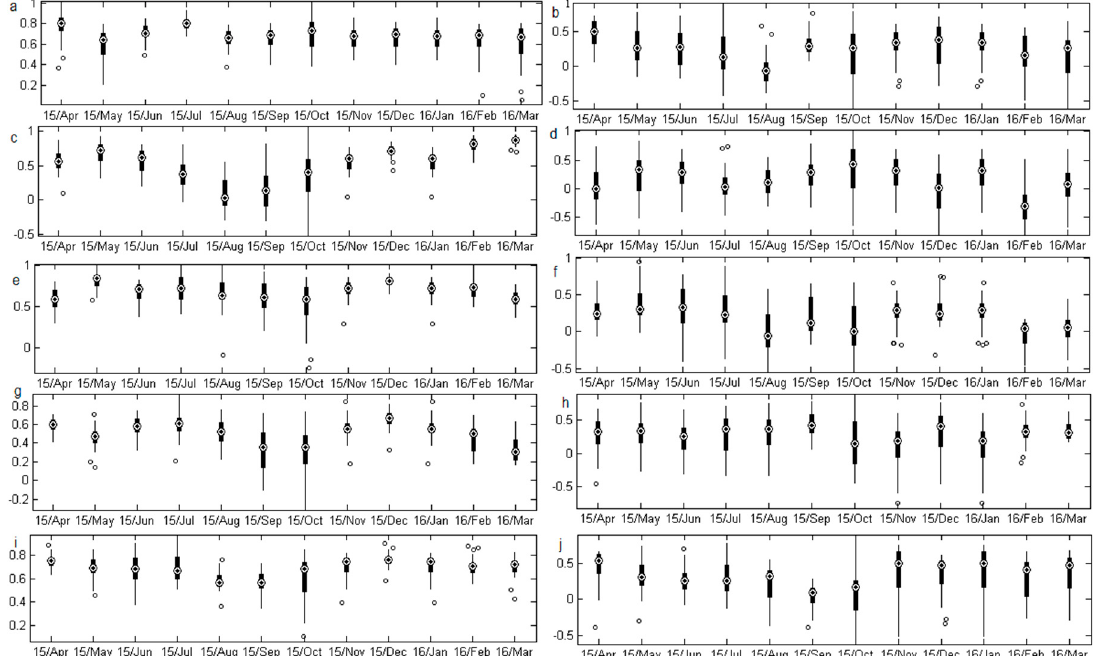
Figure 11. Temporal evolution of correlation between SMAP L4 ( a , c , e , g , i ) or AMSR2 L3 ( b , d , f , h , j ) daily average data and in situ soil moisture data with the Deciduous/Evergreen Forest ( a , b ), Shrub/Scrub ( c , d ), Grassland/Herbaceous ( e , f ), Pasture/Hay ( g , h ) and Cultivated Crops ( i , j ) land cover types in U.S.